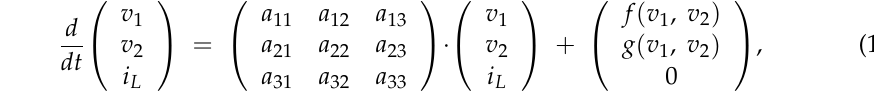
Figure 4. Typical strange attractors generated by analyzed fourth order dynamical system and visualized using 3D subspaces, different internal parameters of second generalized bipolar transistors, namely: ( a ) (cid:101) b = 1.4, ( b ) (cid:101) b = 1, ( c ) (cid:101) y 11 = 0.22. Ranges for individual state variables are v 1 ∈ ( − 1, 1) V, v 2 ∈ ( − 1, 1) V, v 3 ∈ ( − 100, 100) mV, and i L ∈ ( − 100, 100)